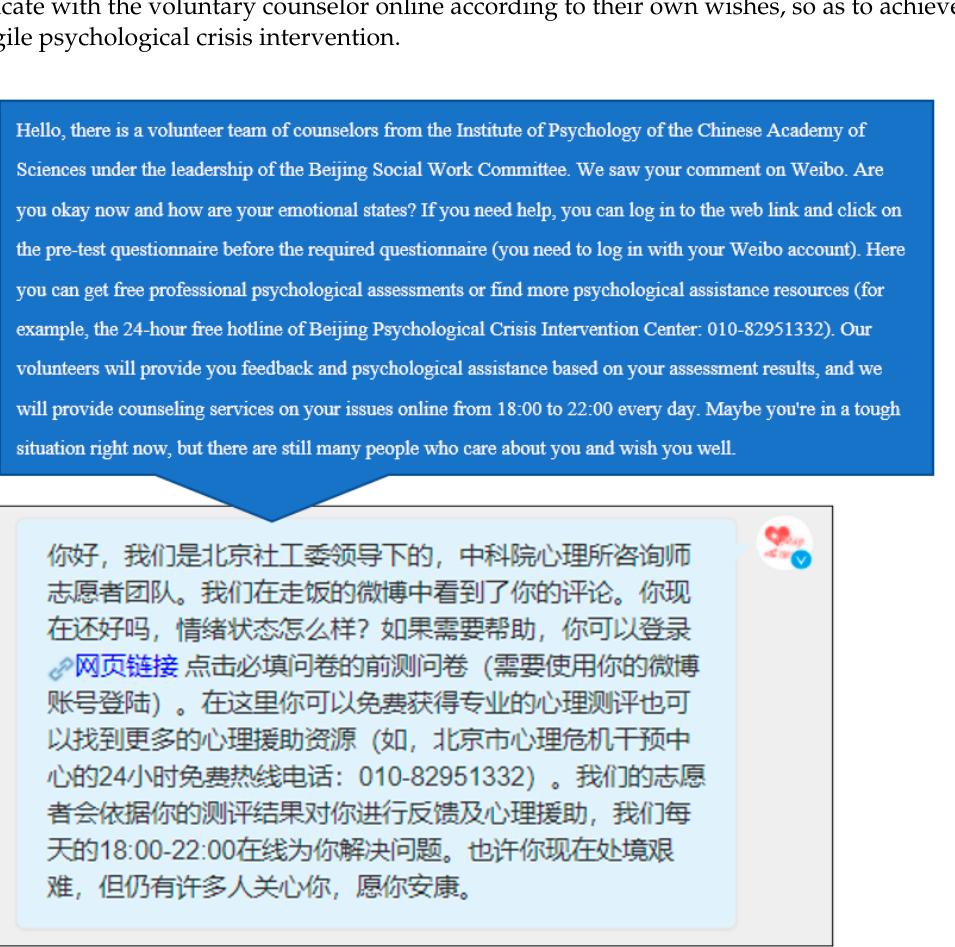
Figure 3. The first private message sent by the Weibo official account.